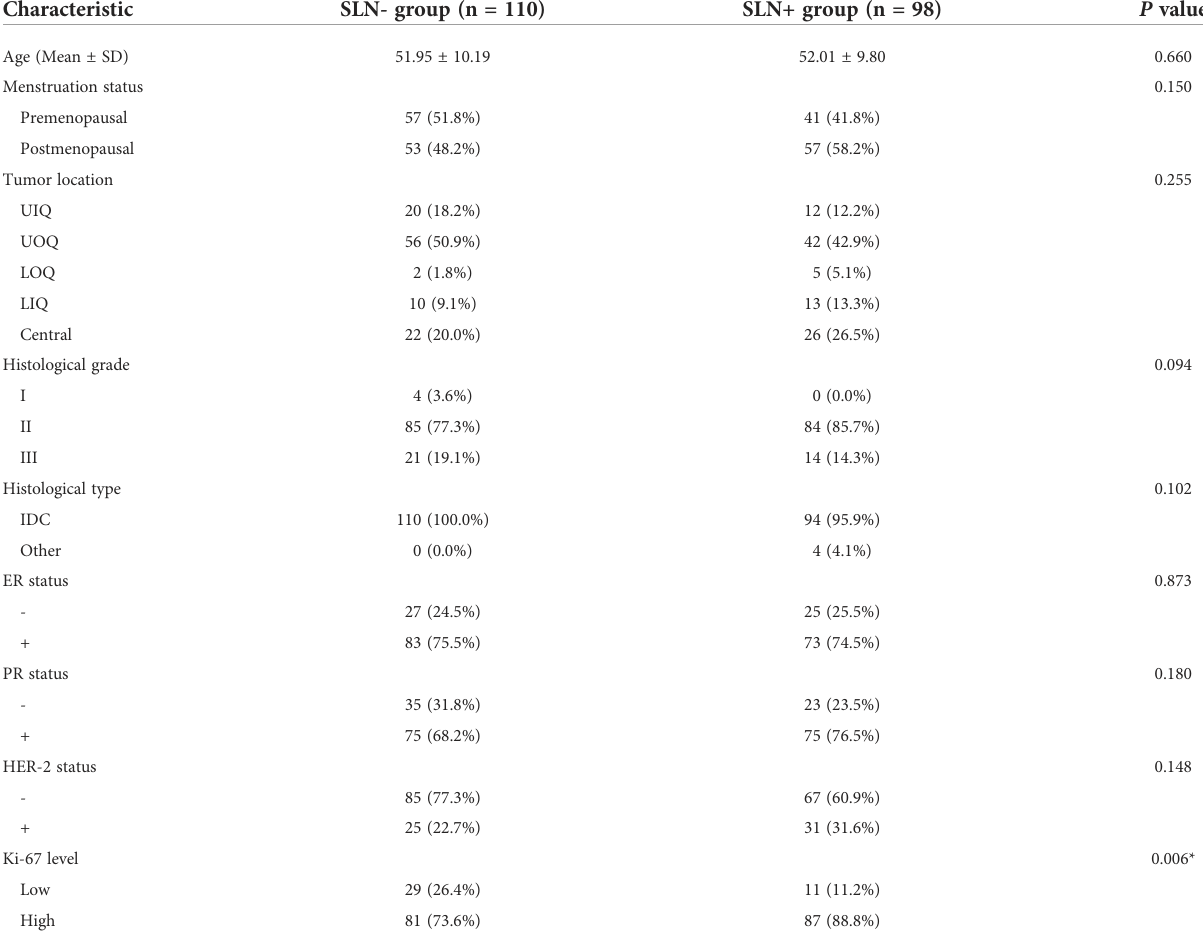
TABLE 1 Patients and clinical